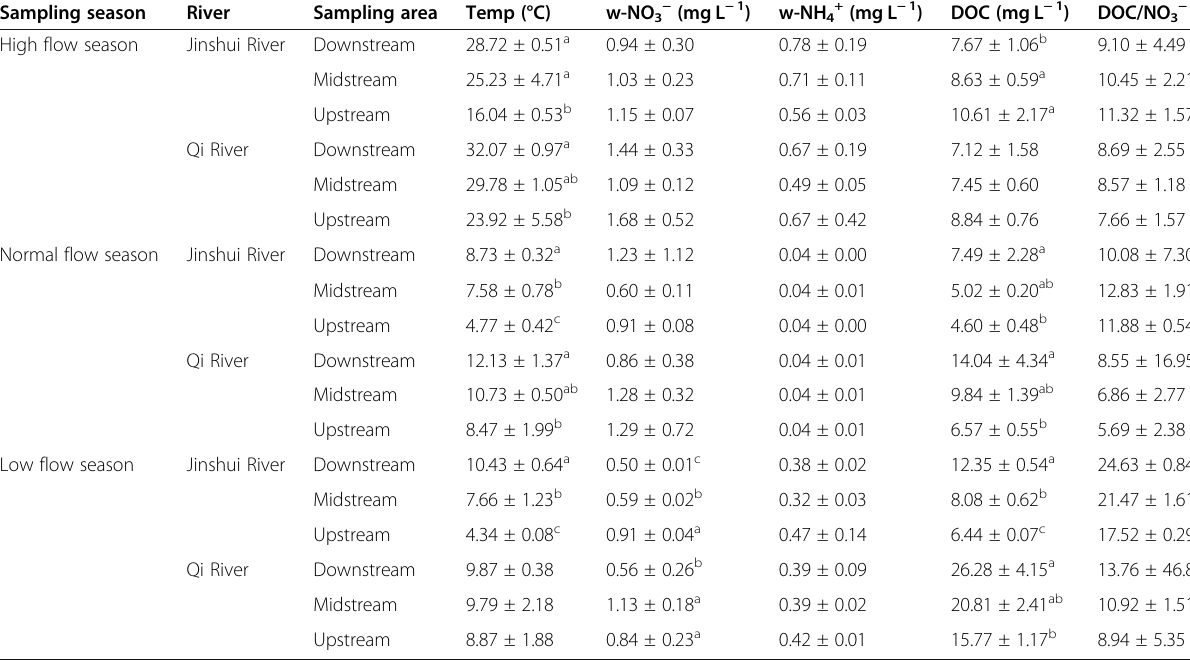
Table 1 Water physicochemical variables of Jinshui River and Qi River Sampling